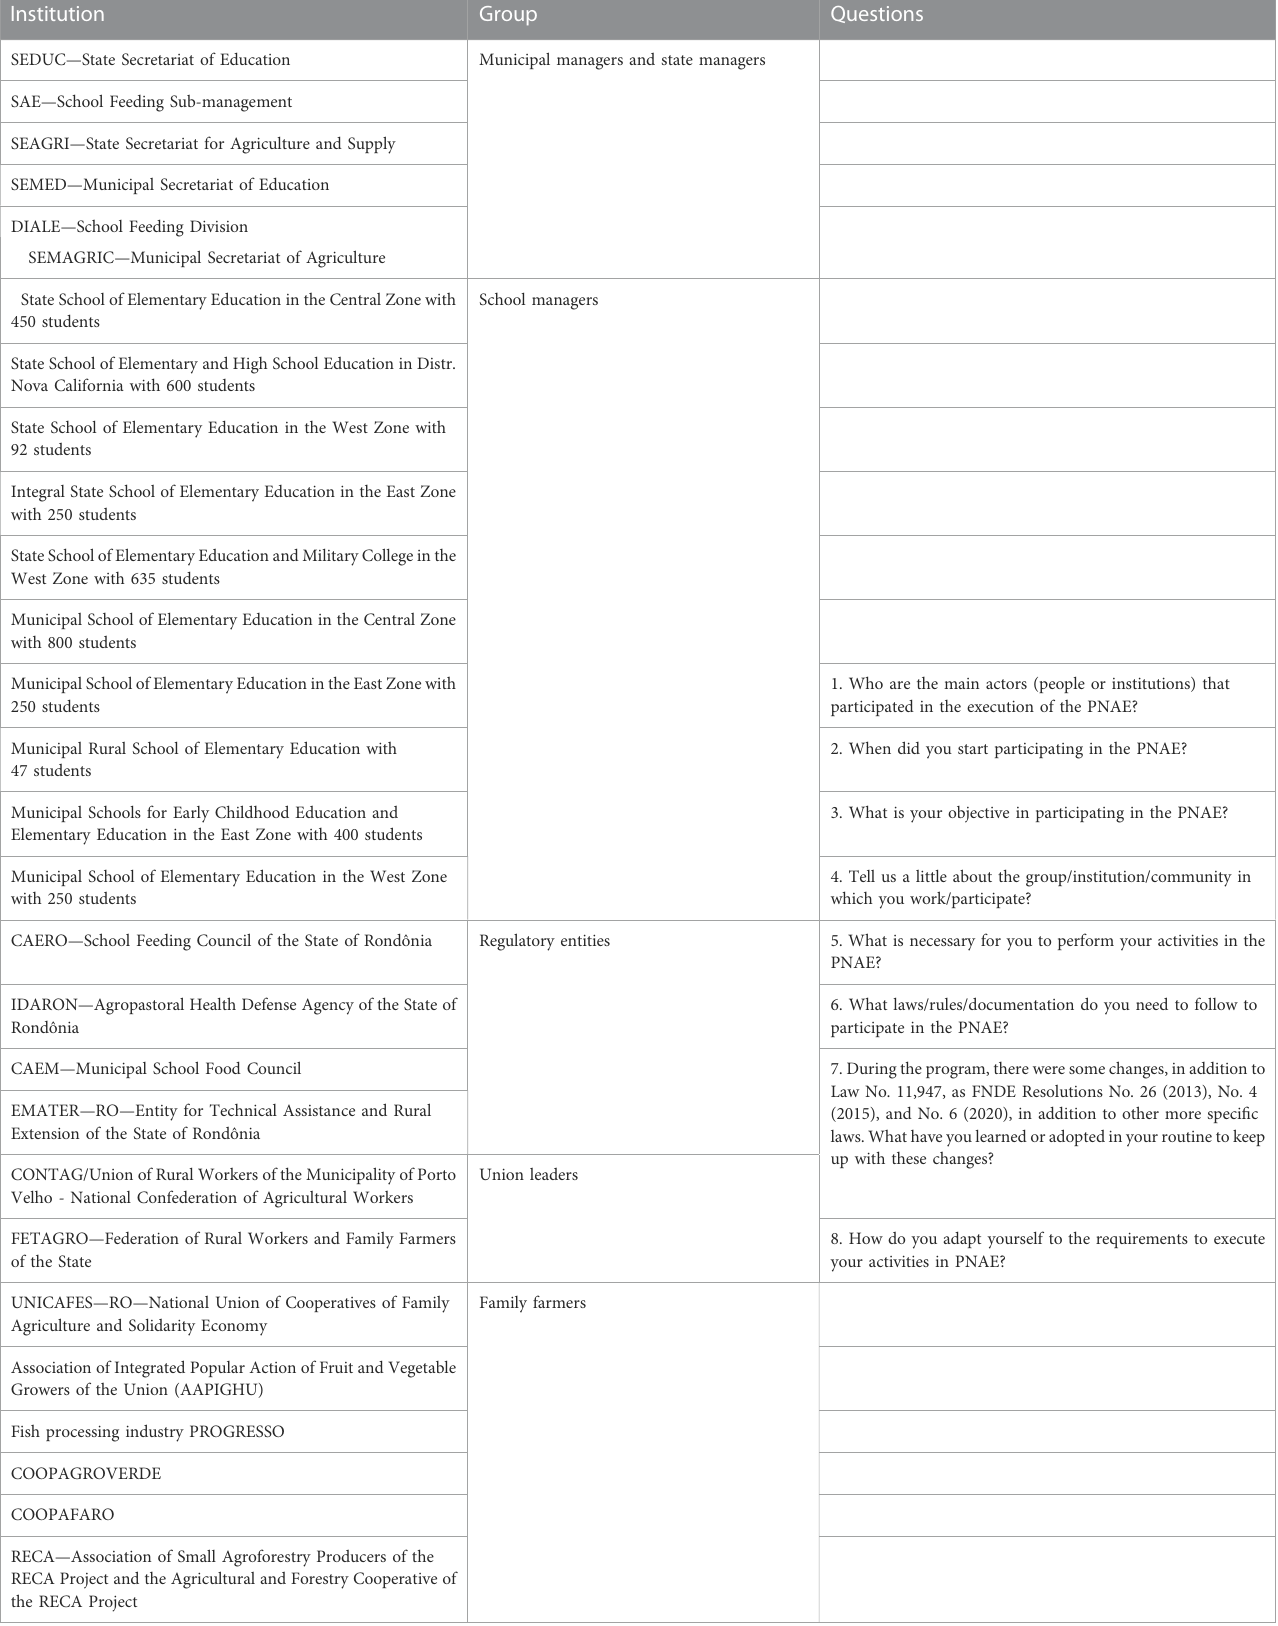
TABLE 2 Interview script 1 for all groups of the PNAE (National School Feeding Program) in the municipality of Porto Velho, State of Rondônia (Brazil), aiming to characterize the activity system generated by Law No. 11,947.